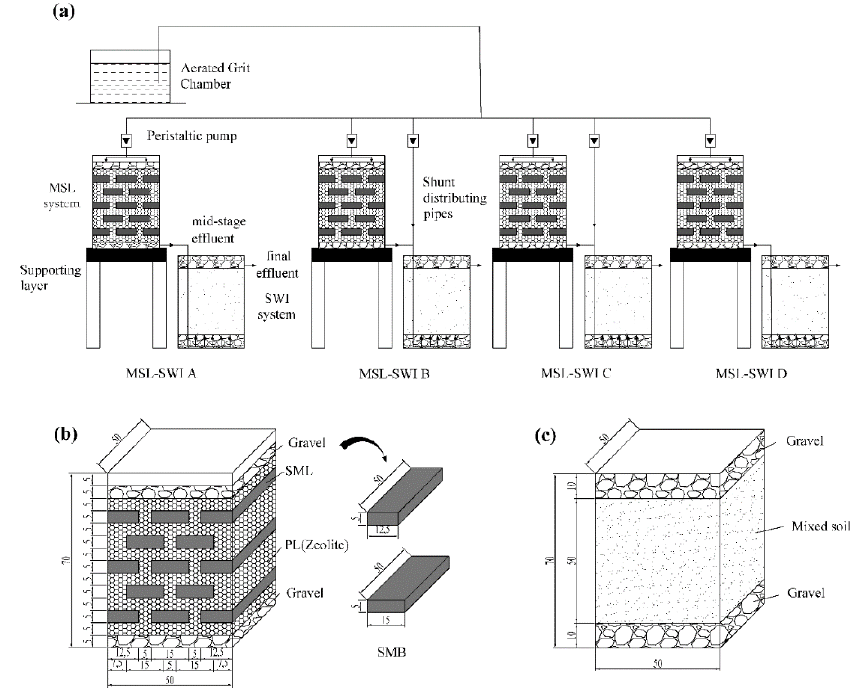
Figure 1. Schematic drawing of the experimental apparatus: ( a ) four multi-soil-layering and subsurface wastewater infiltration (MSL-SWI) systems with different operation modes; ( b ) the MSL section; ( c ) the SWI section. Note: All dimensions are shown in cm.